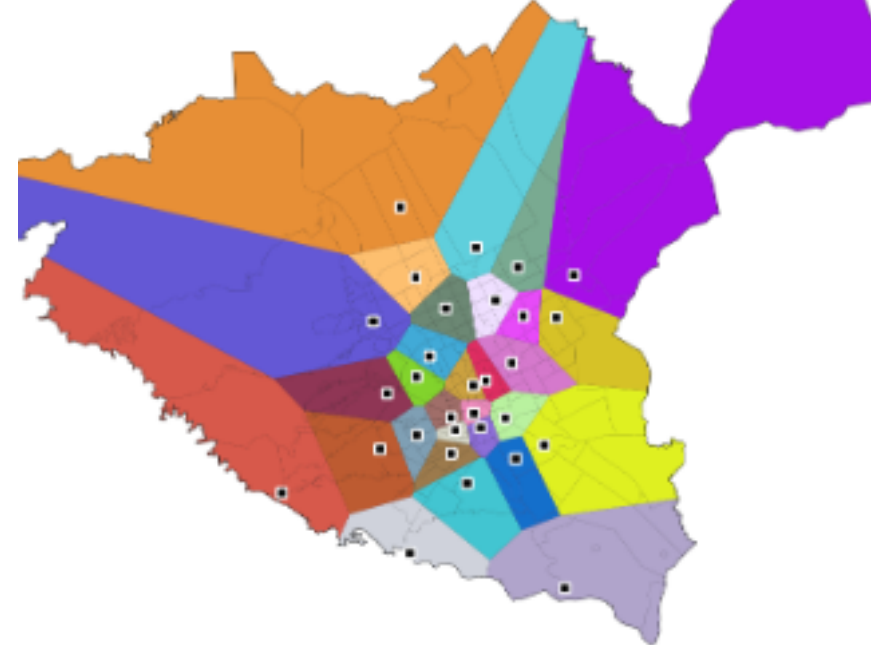
Figure 1. Emergency medical services catchment in Riyadh using Voronoi